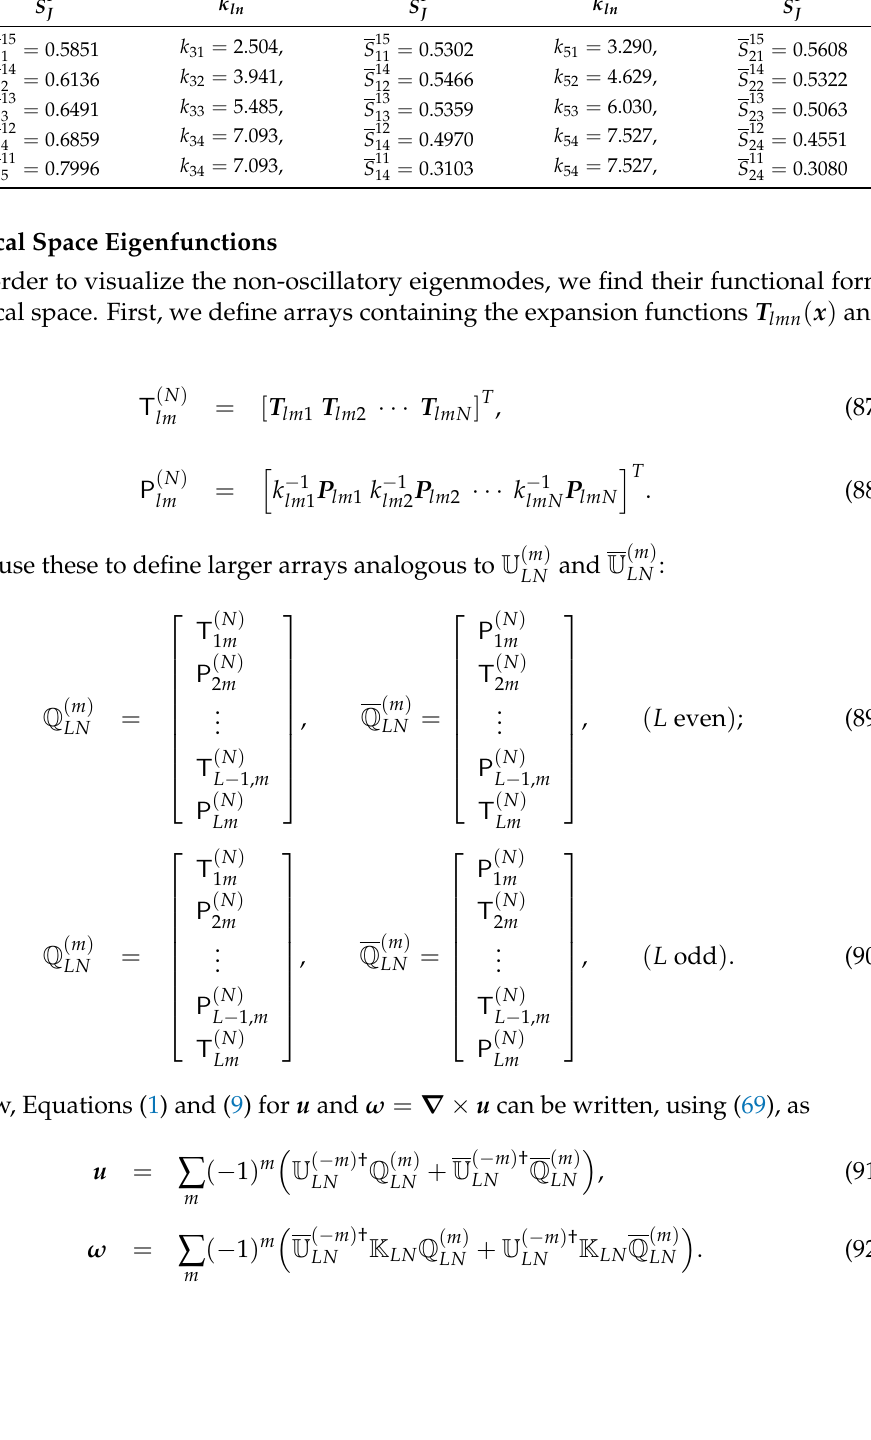
I and S J for each J ( 0 ) = 0 and (cid:60) ω ( 0 ) = 0 eigenmodes, along 55 55